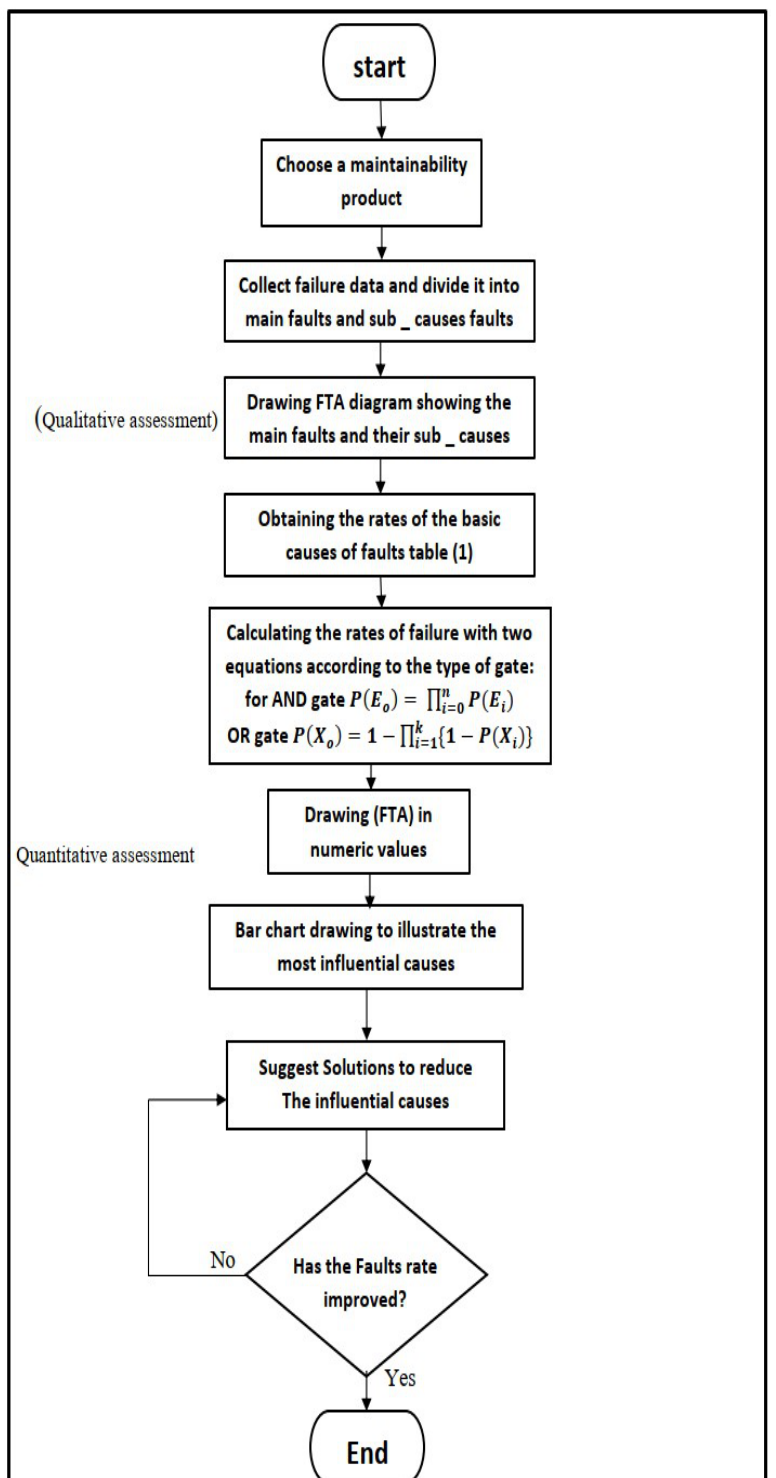
Fig. 2. The flowchart of steps of the processes